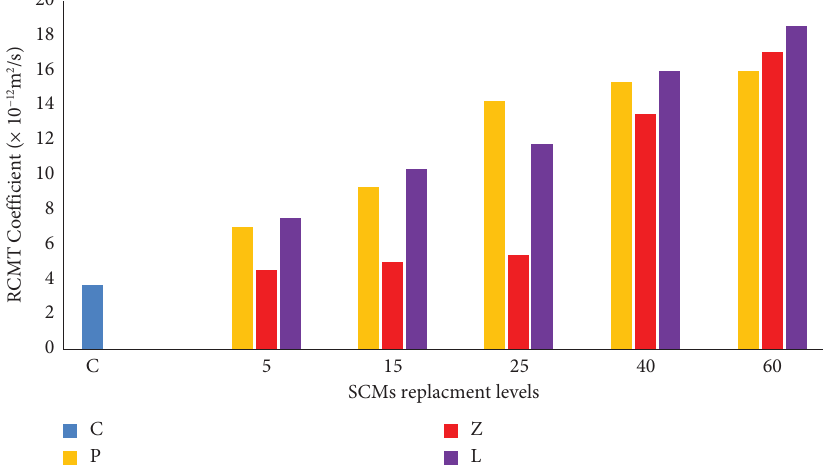
Figure 9: Rapid chloride migration test coefcient of the mixtures at the age of